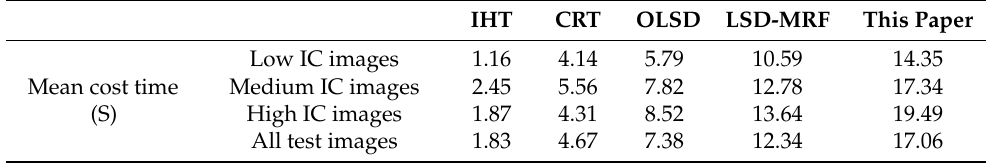
Table 3. Mean time cost on test